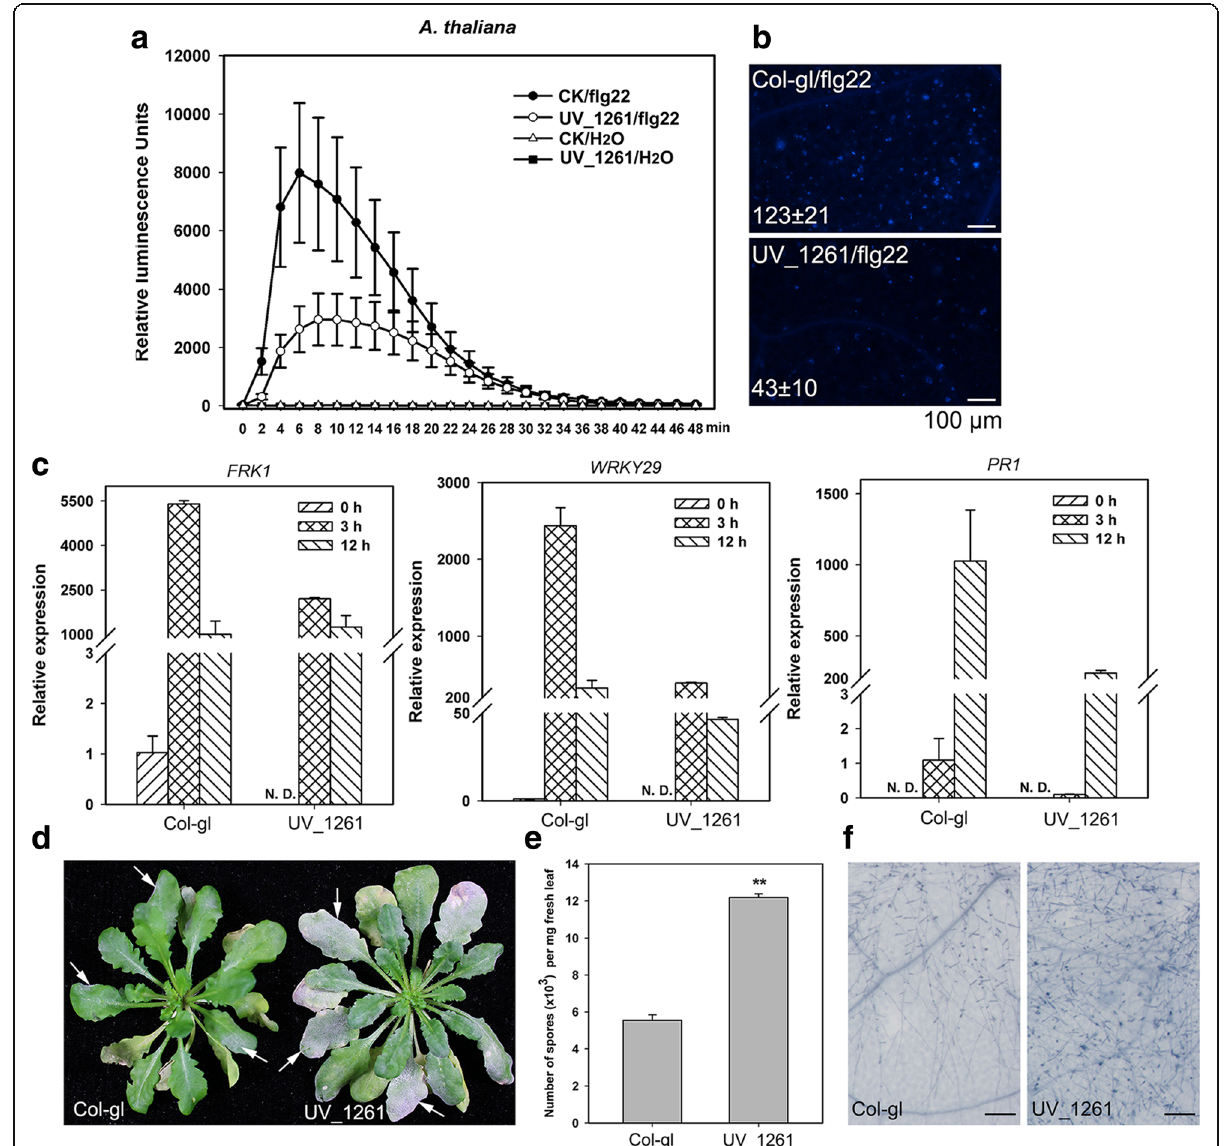
Fig. 3 UV_1261 suppresses plant basal defense responses and promotes powdery mildew infection in Arabidopsis. a Flg22-induced ROS burst in Arabidopsis leaves stably expressing UV_1261 - eYFP or wild-type Col-gl leaves (CK). b Comparison of flg22-induced callose deposition in leaves of UV_1261 - eYFP transgenic plants and Col-gl. c Expression profiling of indicated defense-related genes in UV_1261 - eYFP -expressing Arabidopsis and Col-gl treated with flg22. AtACT2 was used as a reference gene. Relative expression was normalized to that in Col-gl at 0 h, and calculated by the comparative C T method 2 – ΔΔ CT . N. D., not detected. Error bars indicate standard deviations ( n = 3). d Disease symptom of Col-gl and UV_1261-eYFP -expressing Arabidopsis inoculated with powdery mildew isolate Golovinomyces cichoracearum SICAU1. White fungal mass was observed on leaf surface (indicated by white arrows). e Quantification of powdery mildew spores on leaves of indicated plants. Significant difference was determined by the Student ’ s t-test. **, P < 0.01. f Trypan blue staining of infected leaves from Col-gl and UV_1261-eYFP -expressing Arabidopsis. Much more mycelia were seen on UV_1261 -expressing leaves than on Col-gl